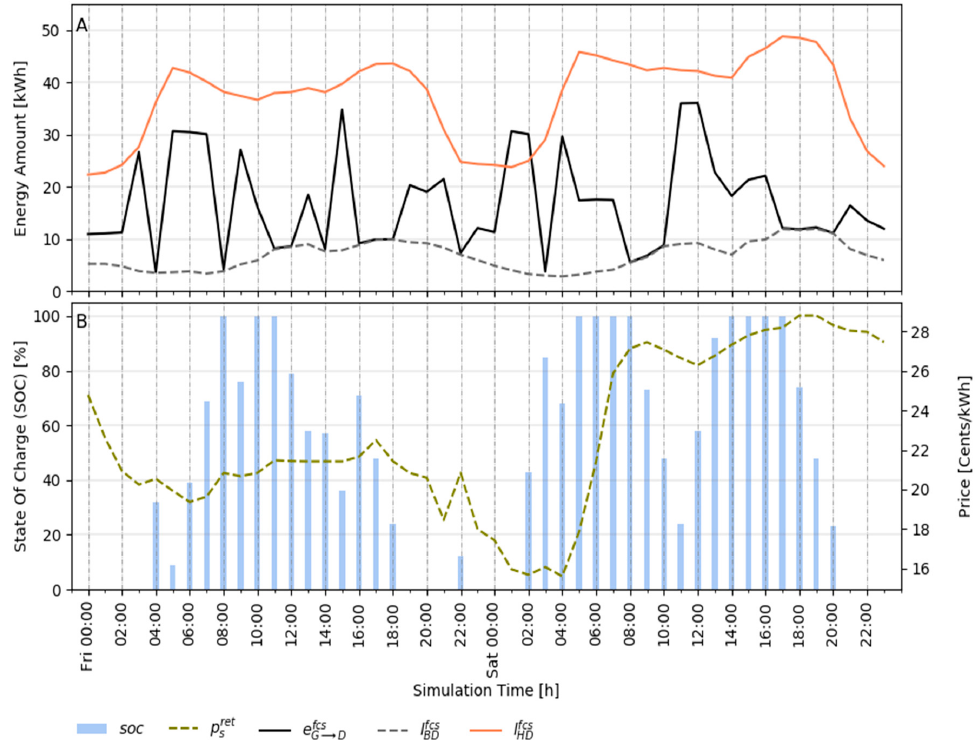
Figure A5. Flexible consumers’ response to the M-RTP tariff for the first 48 h in January. ( A ) Flexible consumers’ heat demand and electricity load; ( B ) state of charge of the thermal storage and electricity tari ff